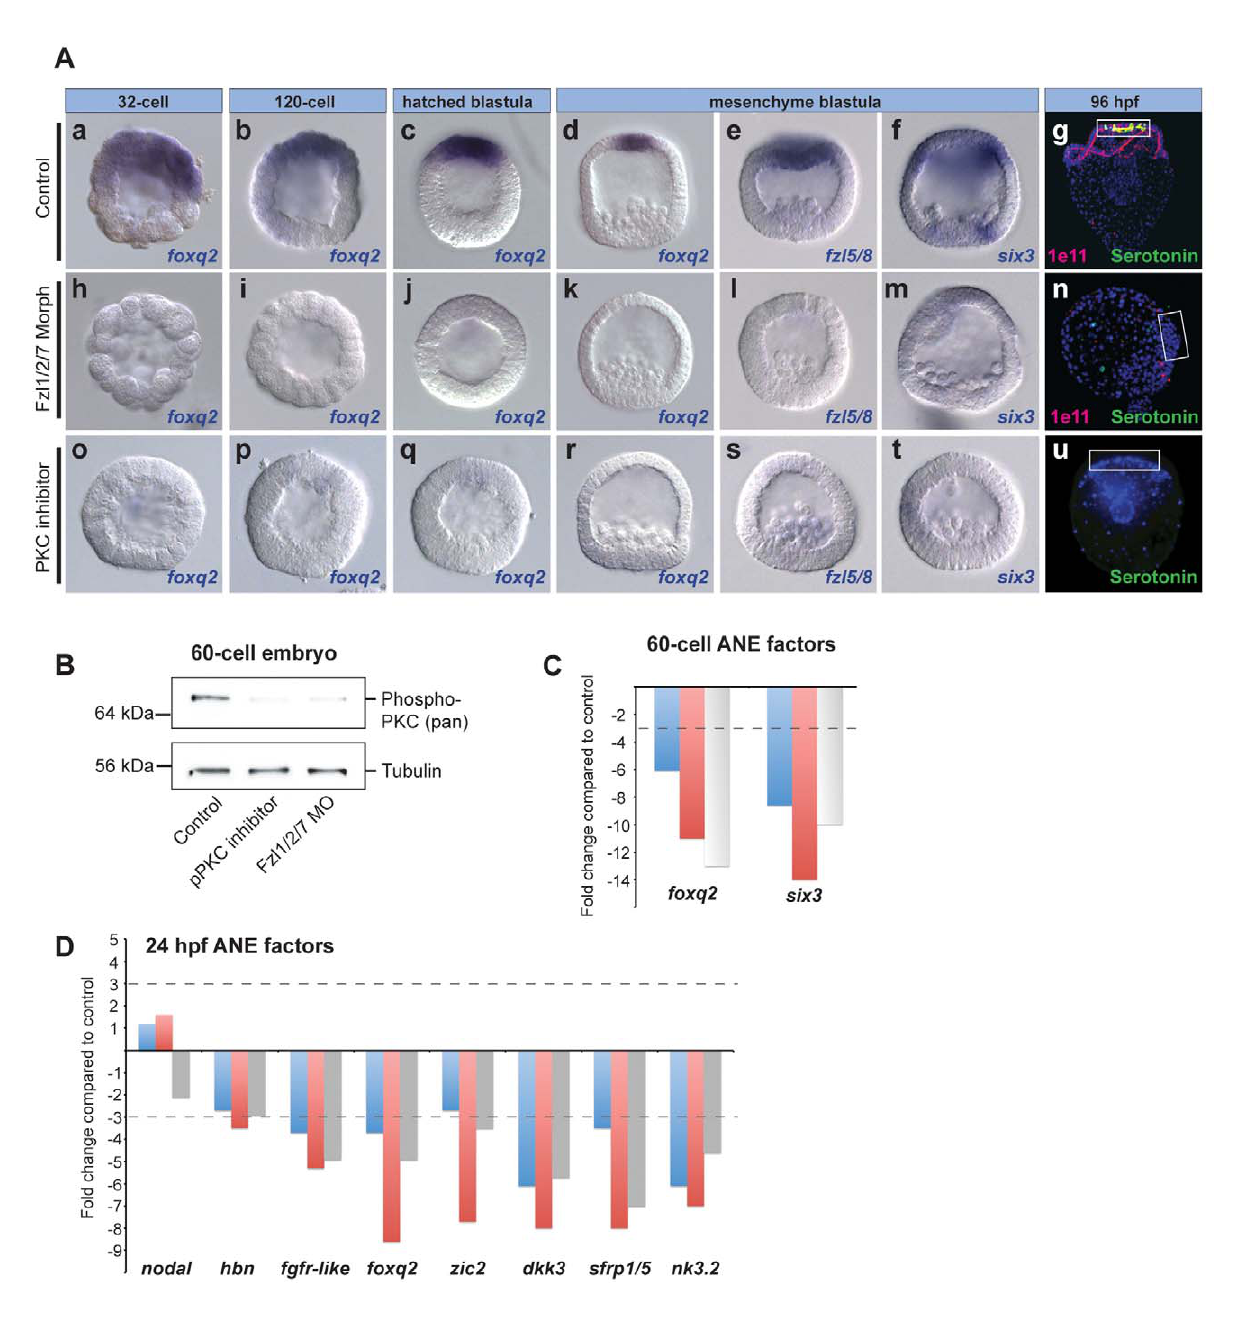
Figure 4. Fzl1/2/7 signaling and PKC activity are necessary for ANE specification. (A) foxq2 expression at stages from 32-cell to hatched blastula, as well as fzl5/8 and six3 expression at mesenchyme blastula stage in control embryos (Aa–f), Fzl1/2/7 morpholino-injected embryos (Ah–m), and embryos treated with PKC inhibitor (Ao–t). (Ag, n, u) Neurons in control, Fzl1/2/7 morpholino-injected, and PKC inhibitor-treated 96-hpf pluteus larvae. White boxes outline the ANE. Serotonergic neurons (green), DAPI (nuclei, blue), synaptotagminB/1e11 (pan-neural, magenta). (B) Western blot showing that phosphorylation of PKC is blocked to similar extents with a PKC inhibitor and Fzl1/2/7 MO. (C, D) qPCR measurements from three different cultures of embryos showing that the early ANE regulatory genes are down-regulated in the absence of Fzl1/2/7 signaling at the 60-cell stage (C) and late blastula stages (D). The y -axis shows the fold change in gene expression level in Fzl1/2/7 morpholino-containing embryos relative to controls. The dotted line marks a 3-fold change in expression. nodal expression is used as an internal control. embryos lacking Fzl1/2/7 and that the loss of foxq2 /ANE fate in but rather it inhibits the Wnt/ b -catenin-dependent ANE restric- tion mechanism. Fzl1/2/7 morphants requires a functional Wnt/ b -catenin path- way. Thus, Fzl1/2/7 signaling is not a positive regulator of the To test if Fzl1/2/7 also antagonizes the Fzl5/8-JNK-dependent initial maternal regulatory state that supports ANE specification, second phase of ANE restriction, we asked whether blocking Fzl5/